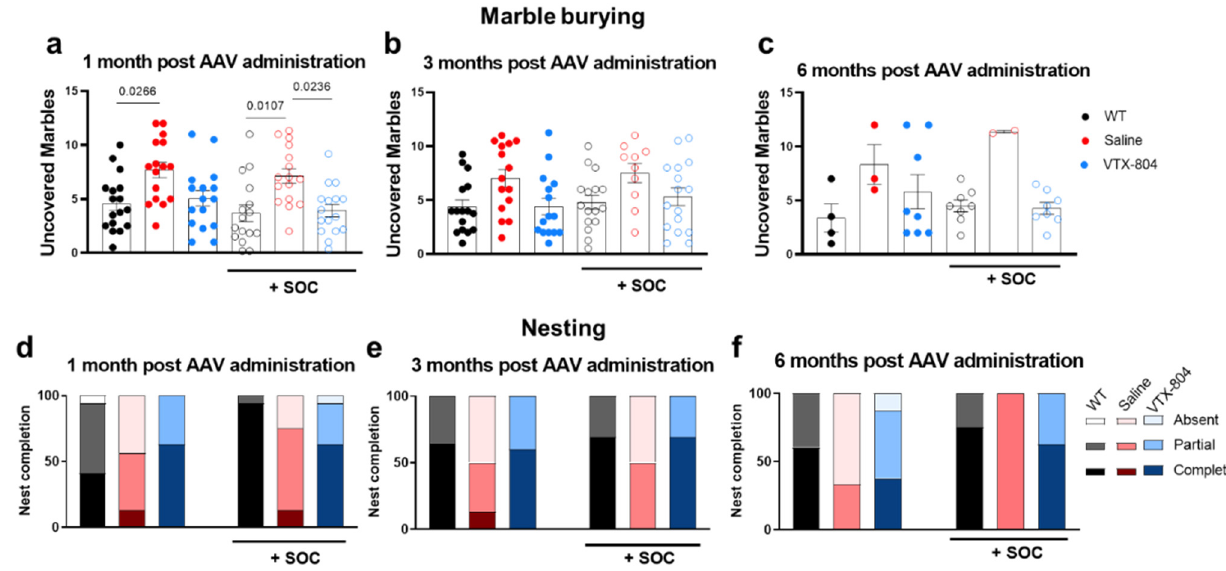
Figure 5. Marble burying and nest building tests. Ass1 fold mice treated with VTX-804 vector with and without SOC from birth to weaning were subjected to the marble burying test one, three and six months after vector administration. Uncovered marbles present in the cage were counted at each time point ( a – c ). The nest building capacity was assessed distinguishing completed, partial and absent nest presence ( d – f ). Groups of animals without SOC treatment: Ass1 fold treated with VTX-804 vector (blue closed circles; n = 15). Controls included untreated Ass1 fold mice (red closed circles; n = 15) and healthy WT mice (black closed circles; n = 19). Groups receiving SOC treatment were: Ass1 fold treated with VTX-804 vector (blue open circles; n = 16). Controls included Ass1 fold mice without vector administration (red open circles; n = 11) and healthy WT mice (black open circles; n = 19). Half of the mice were sacrificed 3 months after vector administration and consequently the six months Wt and VTX-804 groups comprised less animals. Only p < 0.05 values are presented (one-way ANOVA with Bonferroni multiple comparisons test or Kruskal-Wallis with uncorrected Dunn’s test).